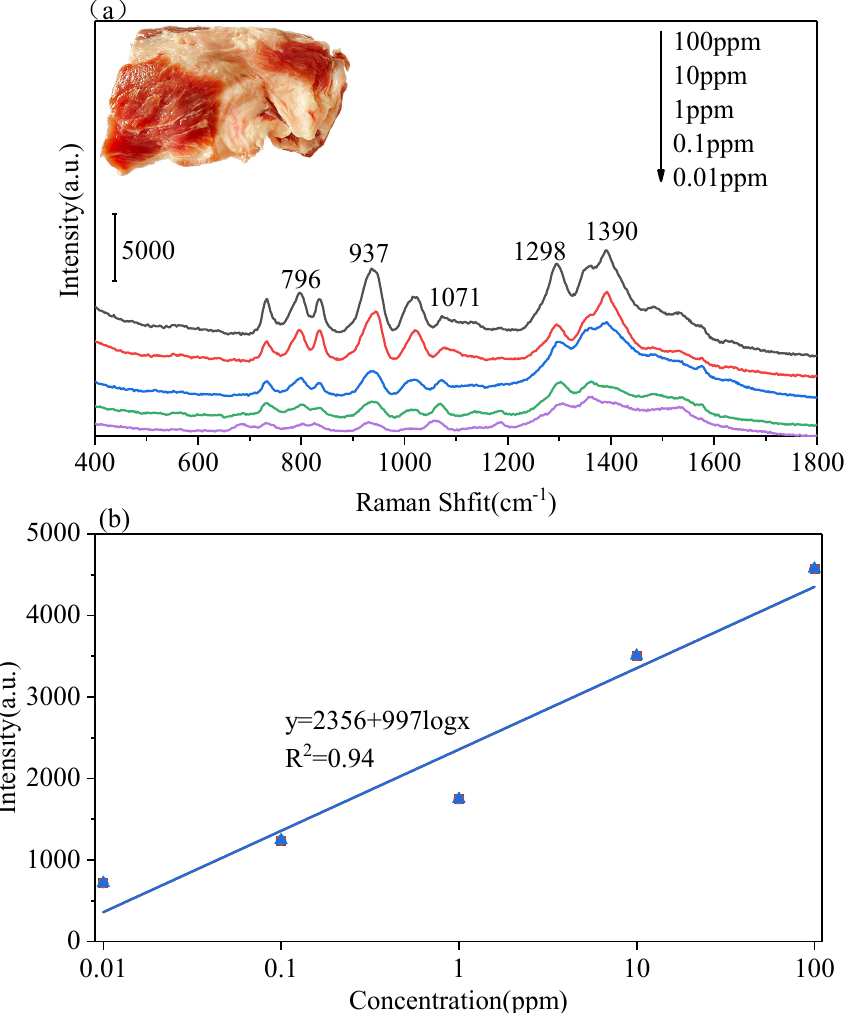
Figure 8. Detection of the DMZ at different concentrations from pork using the LBL PS/Ag sub- strate( a ), Raman intensity as a function of logarithm of DMZ concentration from pork ( b ). Portable Raman spectrometer, laser λ = 785 nm, acquisition time: 2 s.